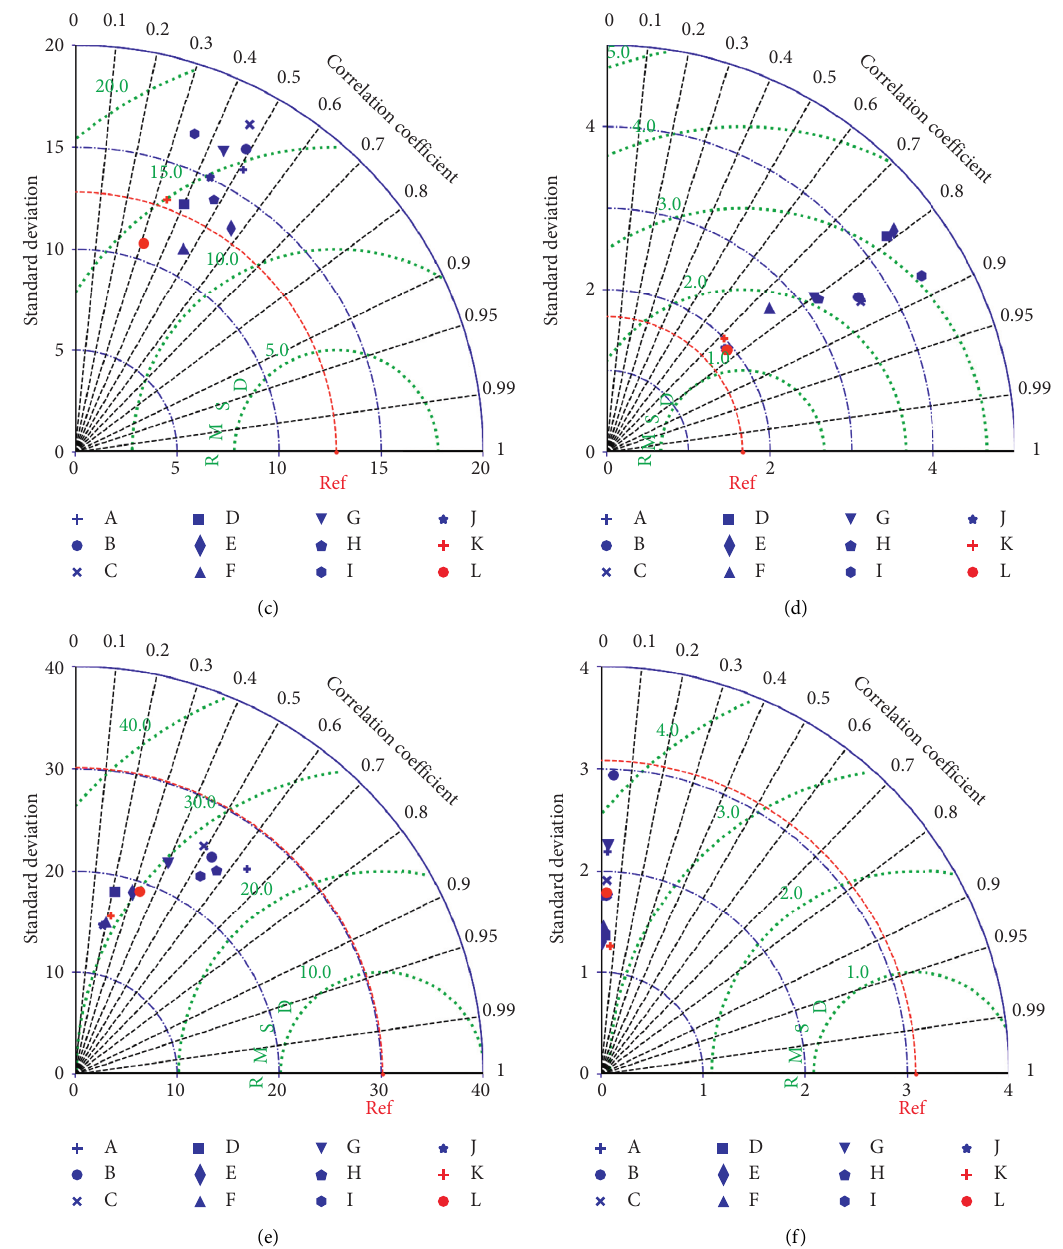
Figure 8: Taylor diagrams with standard deviation, correlation coefficient, and RMSD for each ensemble member for the different regions of Lao PDR. (a) Wet north, (b) dry north, (c) wet center, (d) dry center, (e) wet south, and (f) dry than 6 mm (Figures 8(b), 8(d), and 9(b)). The dry season simulation for southern region demonstrated the worst the southern region in dry period was 0.07, while GSMaP had a negative correlation of − 0.03.